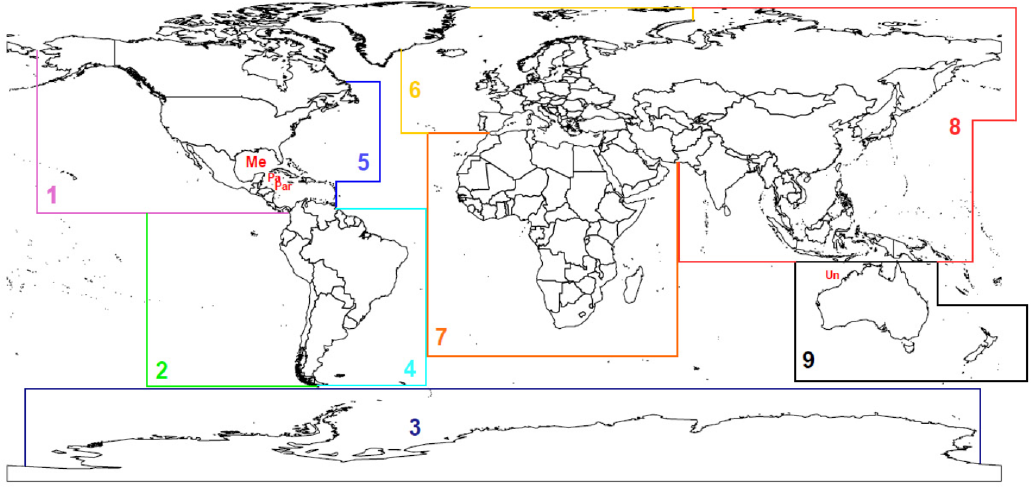
Figure 10. The nine biogeographic areas used for the review of the Orbiniidae diversity distribution with, first, the number of species records and, second, the genera reported for each area. ( 1 ). Pacific North America (42, 10); ( 2 ). Pacific South America (23, 10); ( 3 ). Antarctica (18, 7); ( 4 ). Atlantic South America (33, 9); ( 5 ). Atlantic North America (33, 16); ( 6 ). Europe (31, 11); ( 7 ). Africa (32, 13); ( 8 ). Asia (45, 10); ( 9 ) . Australia and New Zealand (29, 7). The monotypic genera based on the original report are represented: Pa. Paraorbiniella paucibranchiata ; Par. Pararicia belizensis ; Un. Uncorbinia brevibranchiata . The restricted distribution of the monotypic genus Methanoaricia is also marked: Me. M. dendrobranchiata. Map was generated using the R packages ggplot2 and